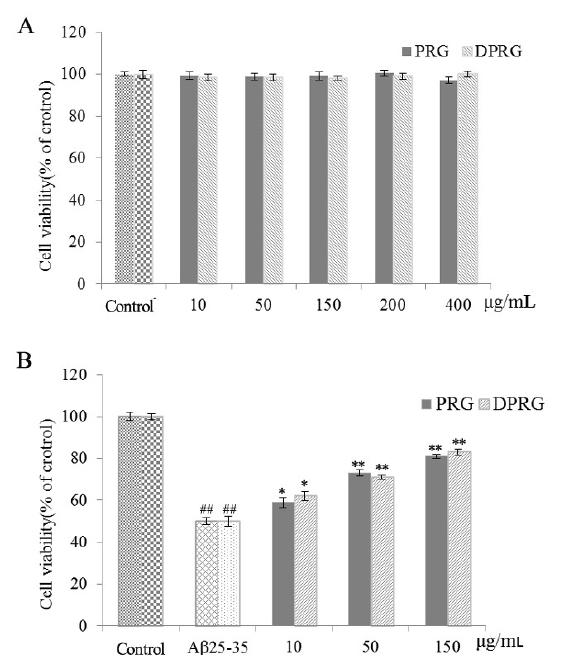
Figure 4. Effects of PRG and DPRG on the viability of PC12 cells in ( A ) basal or ( B